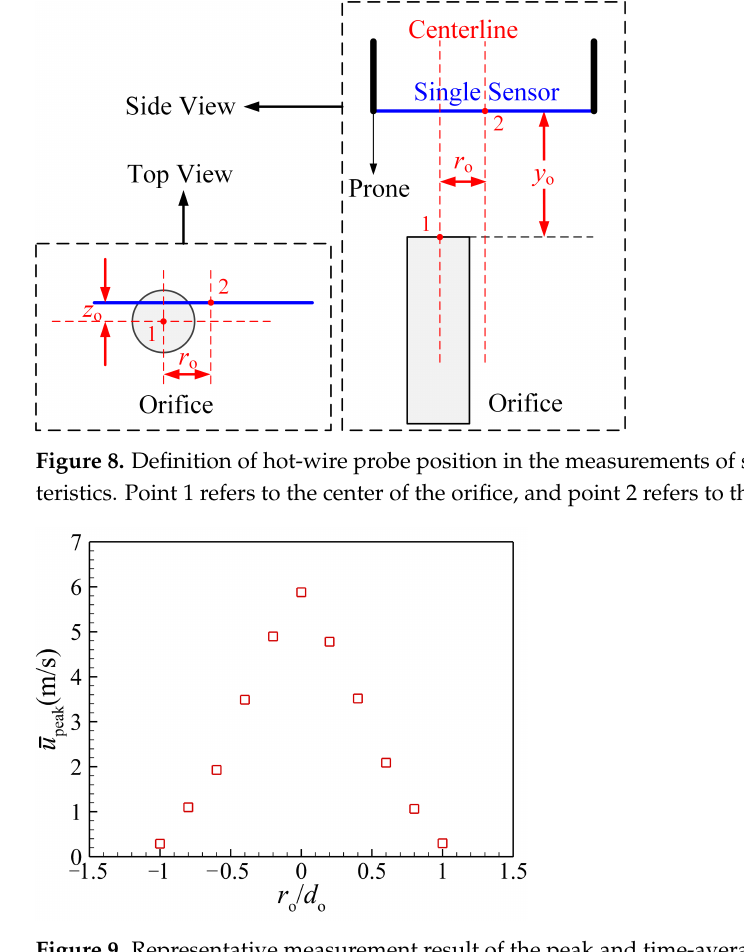
Figure 9. Representative measurement result of the peak and time-averaged blowing velocity of the synthetic jet. The measurement was conducted at z o = 0mm and y o / d o = 1 with varying r o .